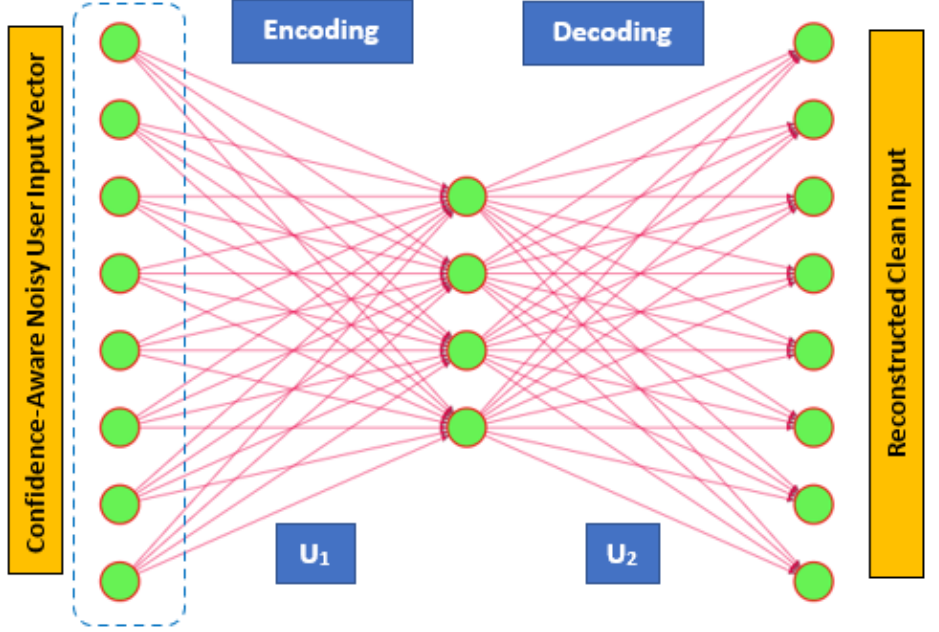
Figure 4. Multi-neural architecture of the proposed CIDAE for an RS. Figure 4. Multi ‐ neural architecture of the proposed CIDAE for an RS .